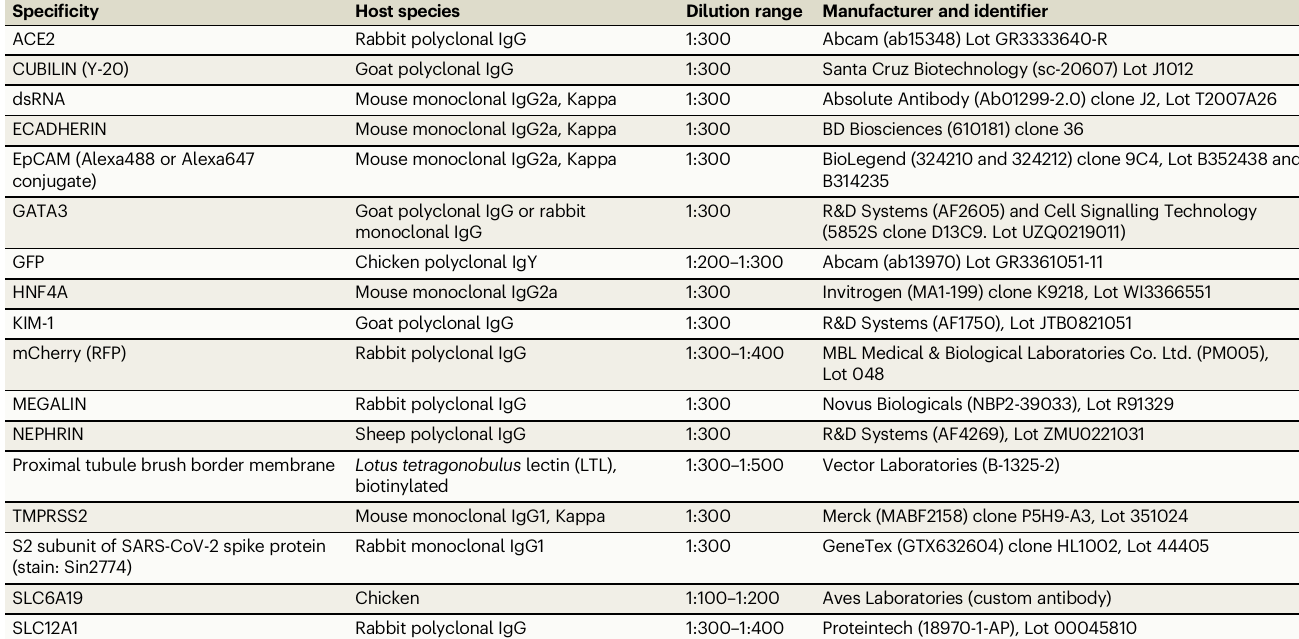
Table 1 | Antibodies used in immuno fl uorescence studies Speci fi